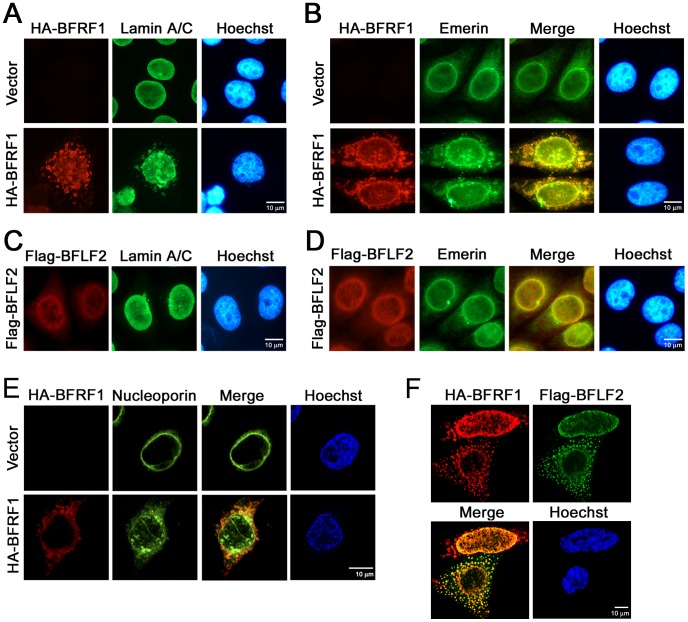
EBV BFRF1 reorganizes the nuclear membrane and induces vesicle formation from the altered membrane.(A to D) Slide-cultured HeLa cells were transfected with a plasmid expressing HA-BFRF1, Flag-BFLF2 or control vector for 24 h. The cells were fixed with 4% paraformaldehyde and stained for HA (A and B, red), Flag (C and D, red), lamin A/C (A and C, green) or emerin (B and D, green), and DNA. Approximately 50∼100 HA-BFRF1 expressing cells were counted to detect the cytoplasmic vesicle associated lamin (A and C) or emerin (B and D) in each set of transfections and all the experiments were repeated independently at least twice. (E) To investigate the effects of BFRF1 on nucleoporins distribution, HeLa cells were transfected with a plasmid expressing HA-BFRF1 or control vector for 24 h, stained for HA-BFRF1 (red) or FG-repeat containing nucleoporins (mAb414, green) and DNA, and analyzed by confocal microscopy. (F) HeLa cells were cotransfected with plasmid expressing HA-BFRF1 and Flag-BFLF2 for 24 h, fixed, stained for HA, Flag and DNA, and analyzed by confocal microscopy.